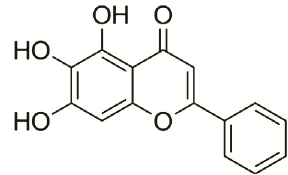
Figure 1. The chemical structure of baicalein.